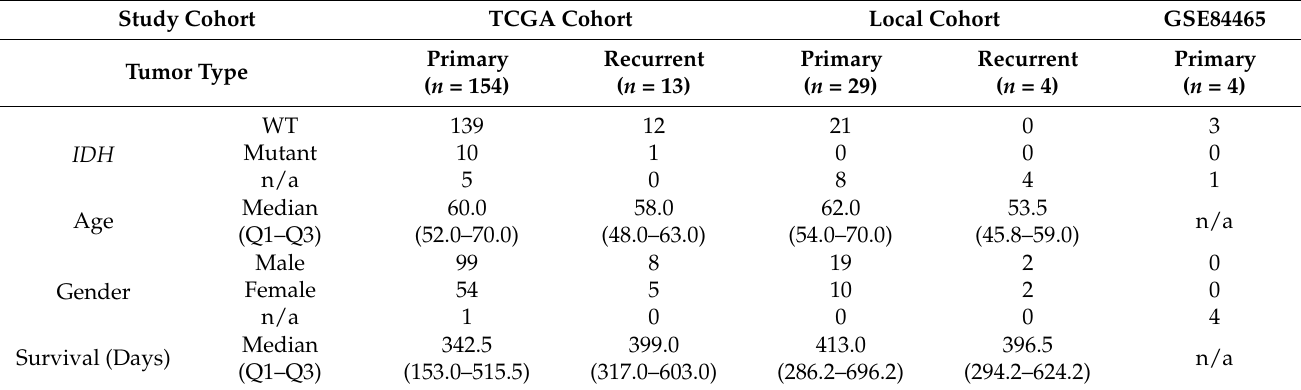
Table 1. Demographic characteristics of patients with GBM in this